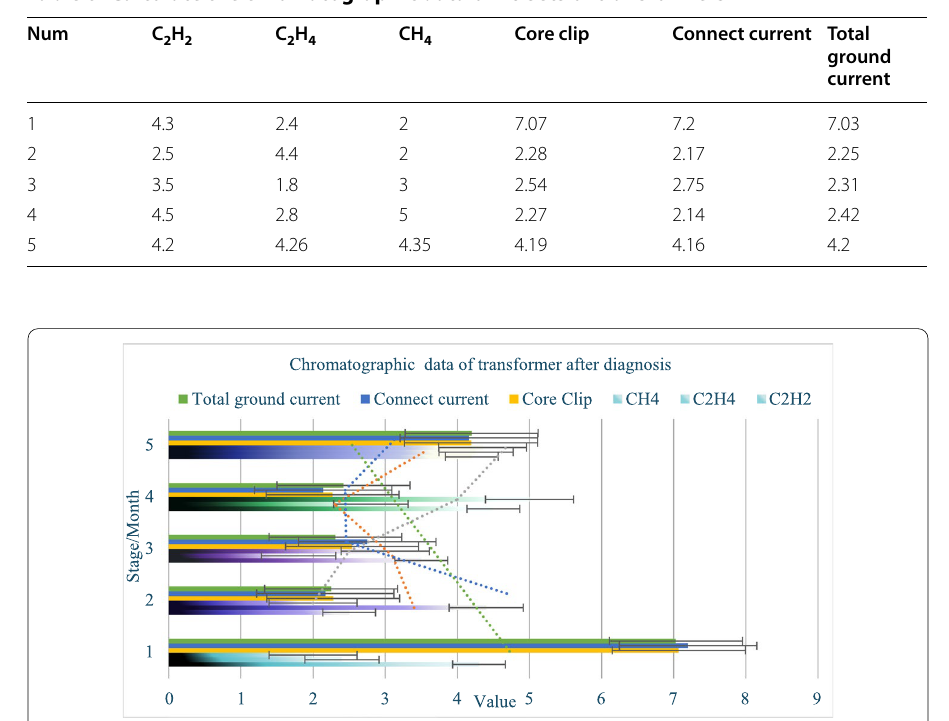
Fig. 8 Chromatographic data of transformer after